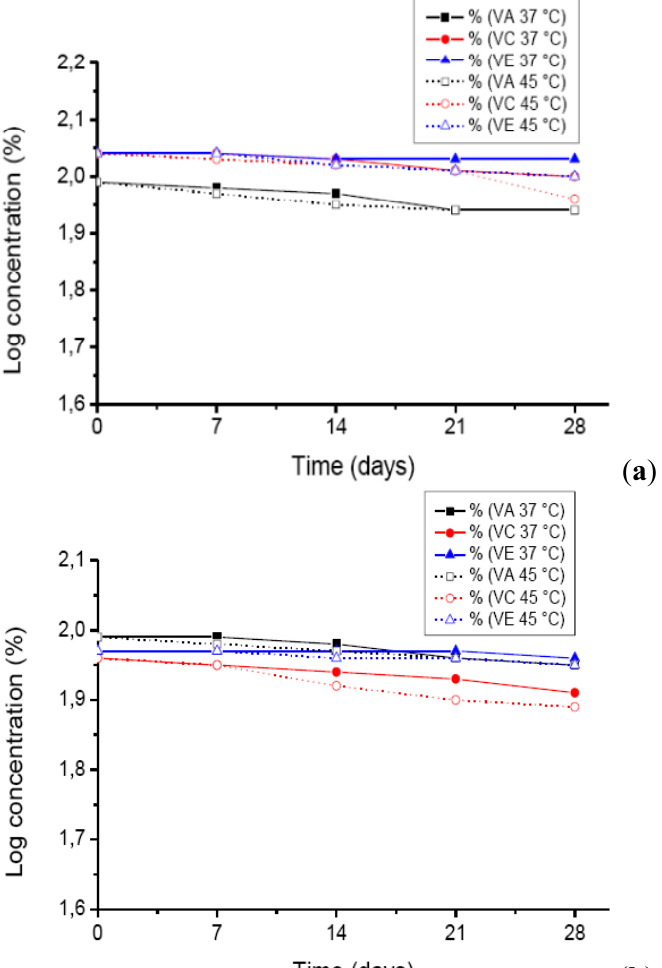
Figure 4. Quantification of vitamin A palmitate (VA), vitamin C (ascorbic acid (VC)) and vitamin E acetate (VE), expressed as logs of concentration values over time, when added, alone ( a ) or in combination ( b ) to the formulation under study stored at 37 and 45 °C with 75%